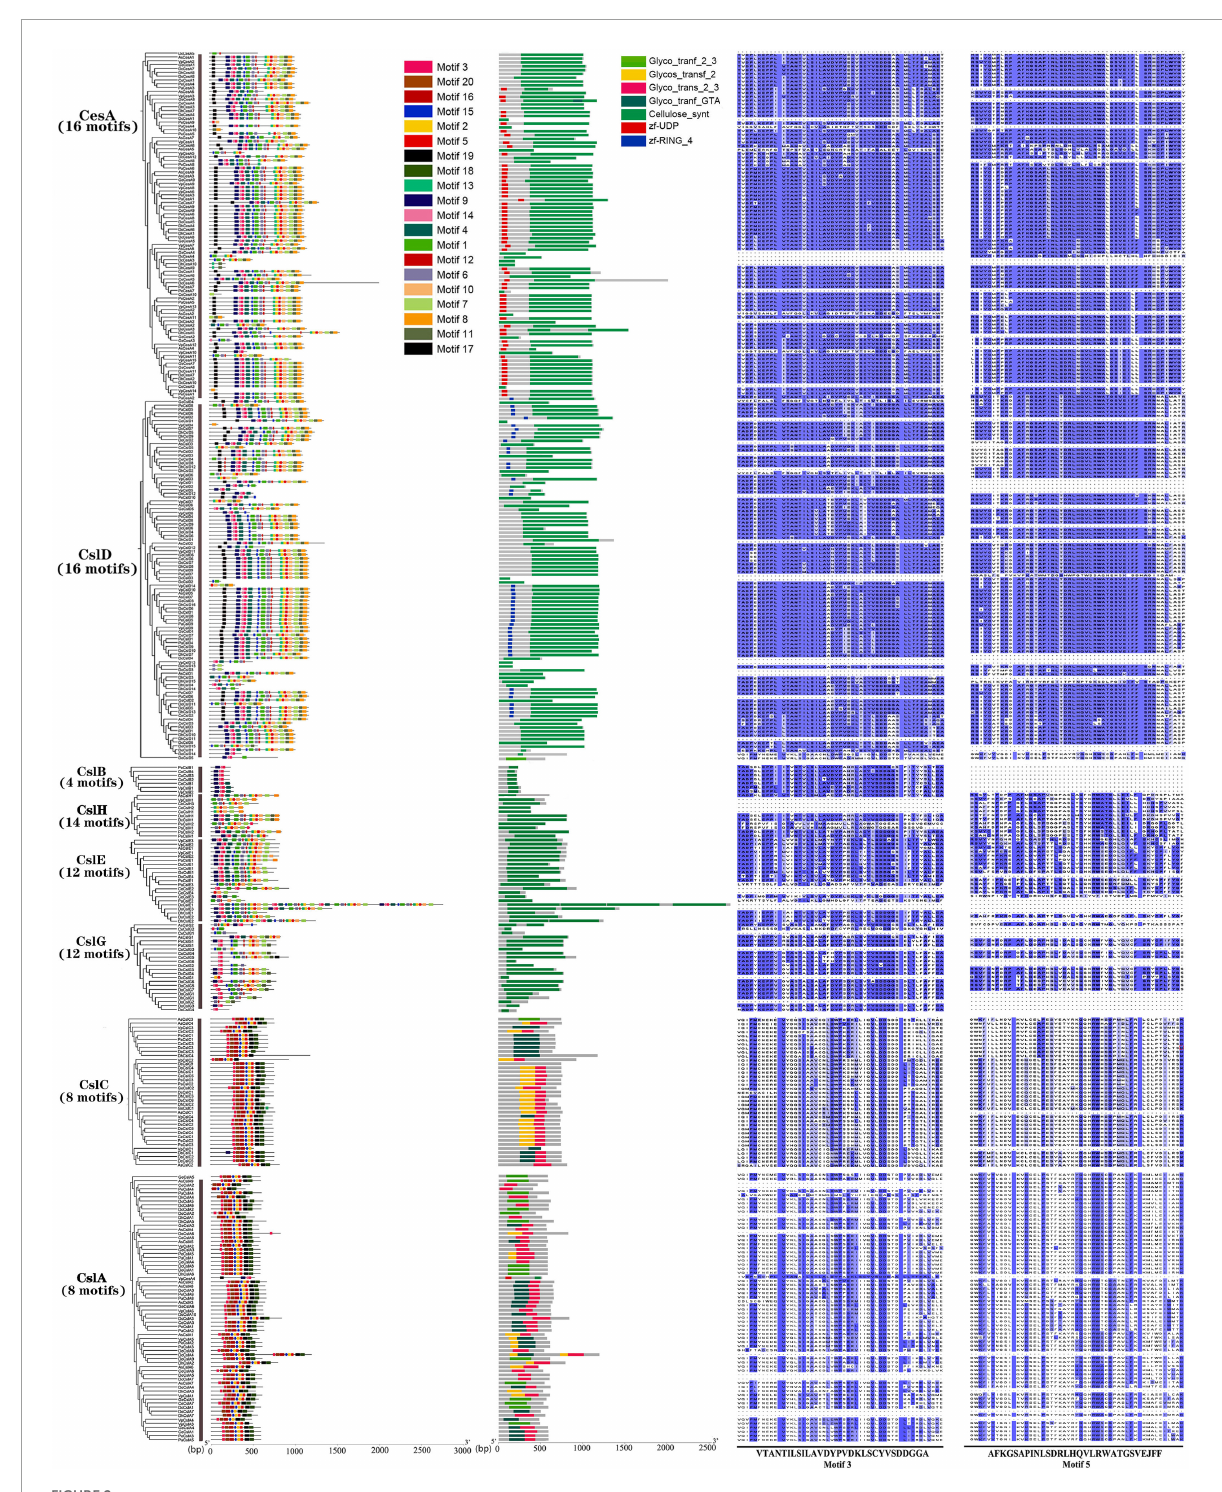
FIGURE2 Protein motifs, conserved domains, and amino acid sequences of represented motifs (Motif 3 and Motif 5) corresponding eight CesA/Csl subfamilies in nine orchid species. Nine orchids have 20 types of motifs (Motif 1-Motif 20) and six types conserved domains: Cellulose_synt, Glyco_trans_2_3, Glyco_tranf_2_3, Glyco_tranf_2, Glyco_tranf_GTA_type, and